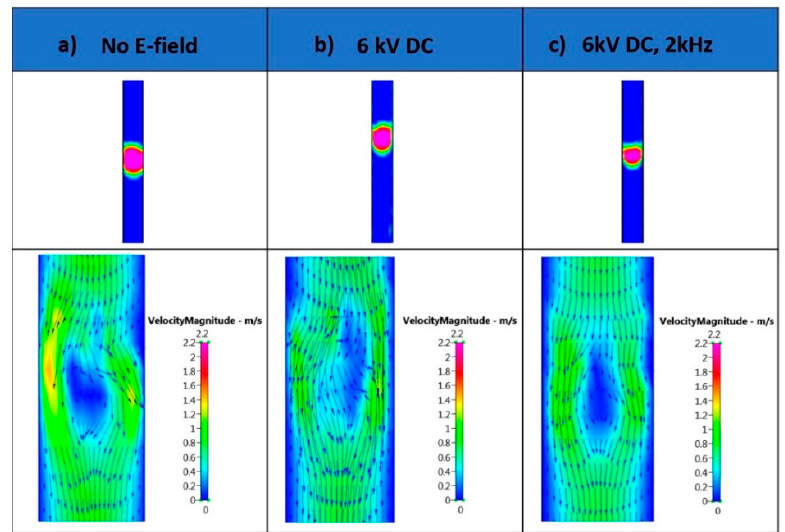
Figure 6. Velocity magnitude vector plots of the microbubble with ( a ) no electric field; ( b ) 6 kV DC; and ( c ) 2 kV P–P AC, 6 kV DC, 2 kHz.